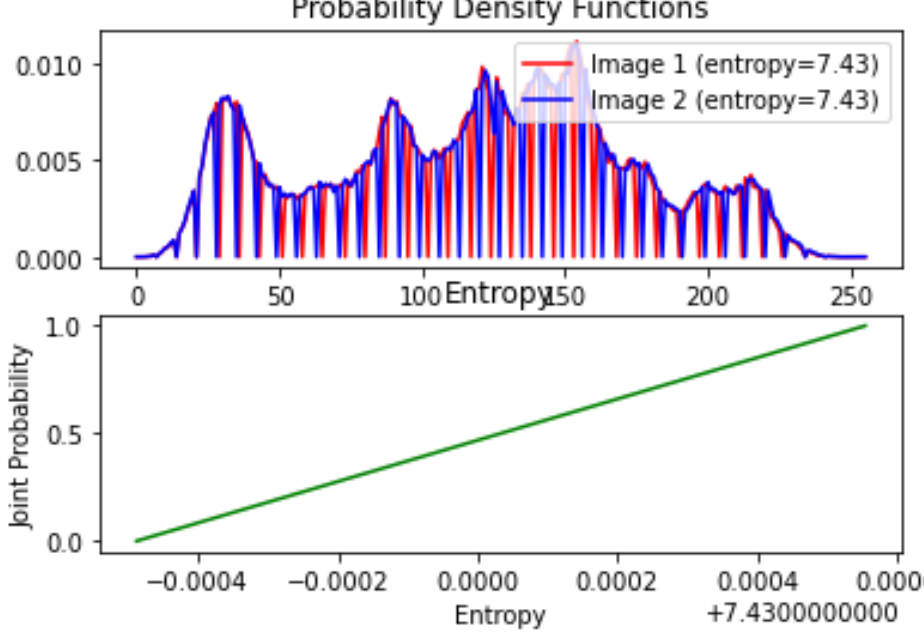
Figure 9. Information entropy analysis of the proposed method.